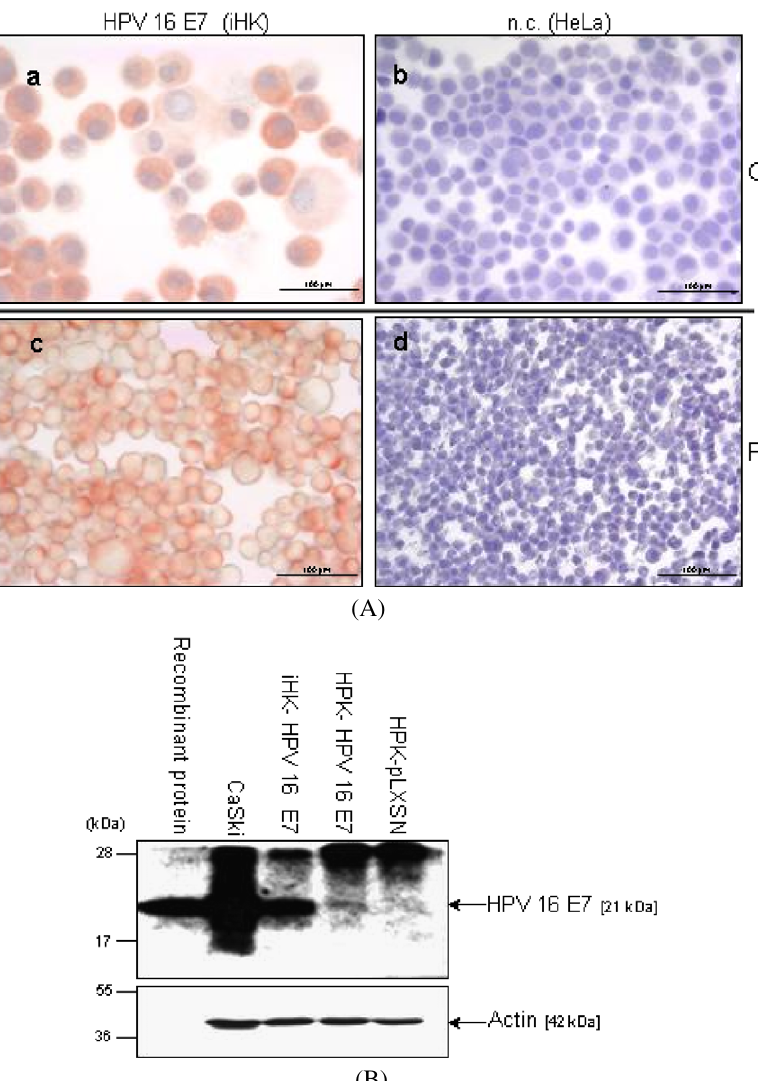
Fig. 1. Detection of HPV 16 E7 protein in transfected human primary keratinocytes (HPK). (A) For immunocytochemistry, either cytospins (a, b) or sections of formalin fixed and paraffin-embedded cells (c, d) were used. Protein expression of HPV 16 E7 in i mmortalized h uman foreskin k eratinocytes (iHK) in a ration of 1:1 (HPV 16 E6 and HPV 16 E7) (a, c) or HPV 18 positive HeLa cells (b, d). The HPV 16 E7 protein could be detected in the cytoplasma of both the cytospins and paraffin-embedded iHK using the monoclonal antibody (Zymed, clone 8C9, diluted 1:2). Specificity was shown with HeLa cells, which were negative under these conditions. (B) Western blot analysis was performed with whole protein extracts (100 µg/lane) of cell lines or 30 pg purified recombinant HPV 16 E7 protein separated in a 12% polyacrylamid gel. Monoclonal antibodies were used to detect HPV 16 E7 (clone nm2, diluted 1:2,000; kindly provided by M. Müller, DKFZ, Heidelberg) or Actin (MP biomedicals, clone C4, diluted 1: 40,000). Detection was performed using the enhanced chemiluminescence (ECL) substrate according to the manufacturer’s instructions (“super signal west femto maximum sensitivity substrate”, Pierce Biotechnology, Rockford, USA). The highest HPV 16 E7 protein amounts were present in CaSki cells, followed by iHK, and only weak expression was observed in retroviral-infected HPK. (n.c., negative control; C, cytospins; P, sections of paraffin-embedded